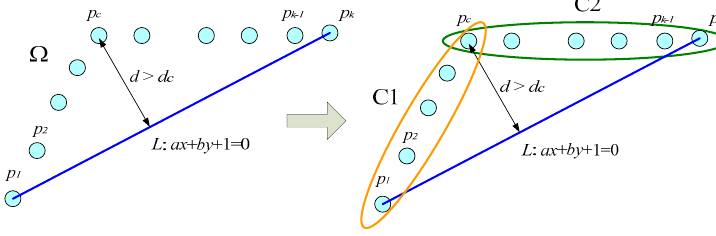
Figure 3. Illustration of the split and merge scheme.